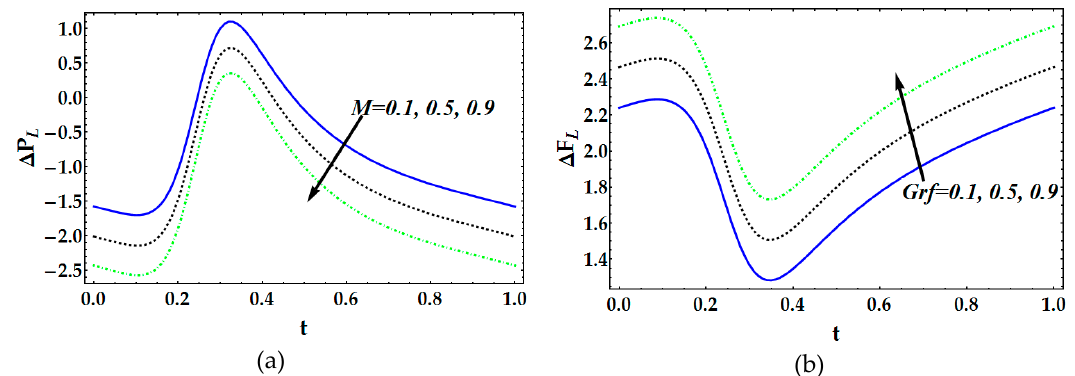
Grt and 𝐺 (cid:3045)(cid:3033) .